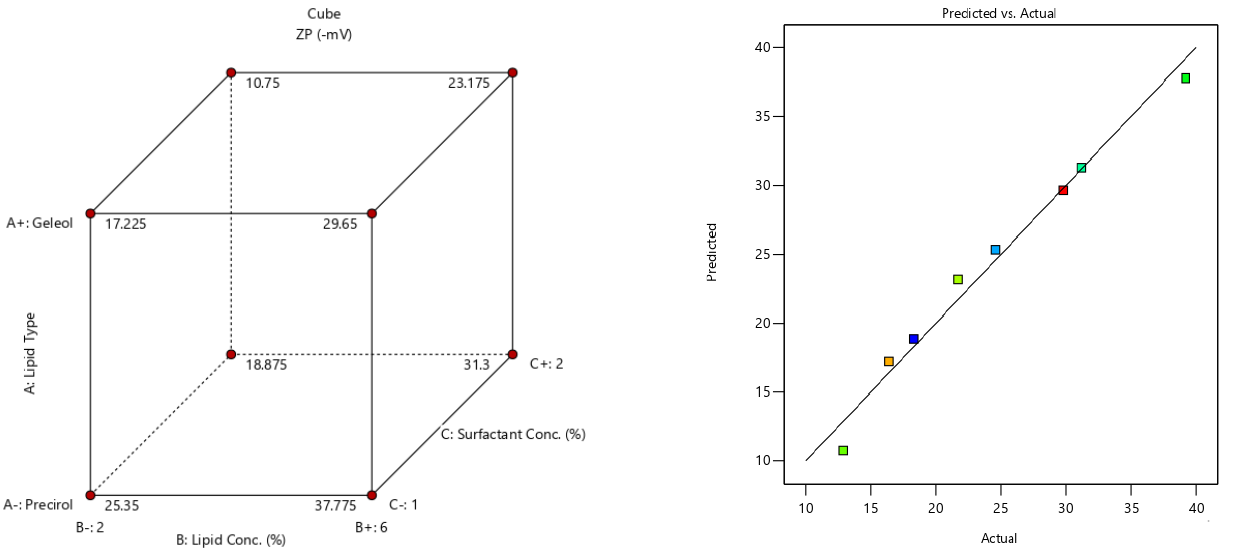
Figure 13. The impact of A: Lipid type, B: Lipid conc., C: surfactant conc. on ZP of 4h-loaded NLC is represented in cubic plot and predicted versus actual values plot.